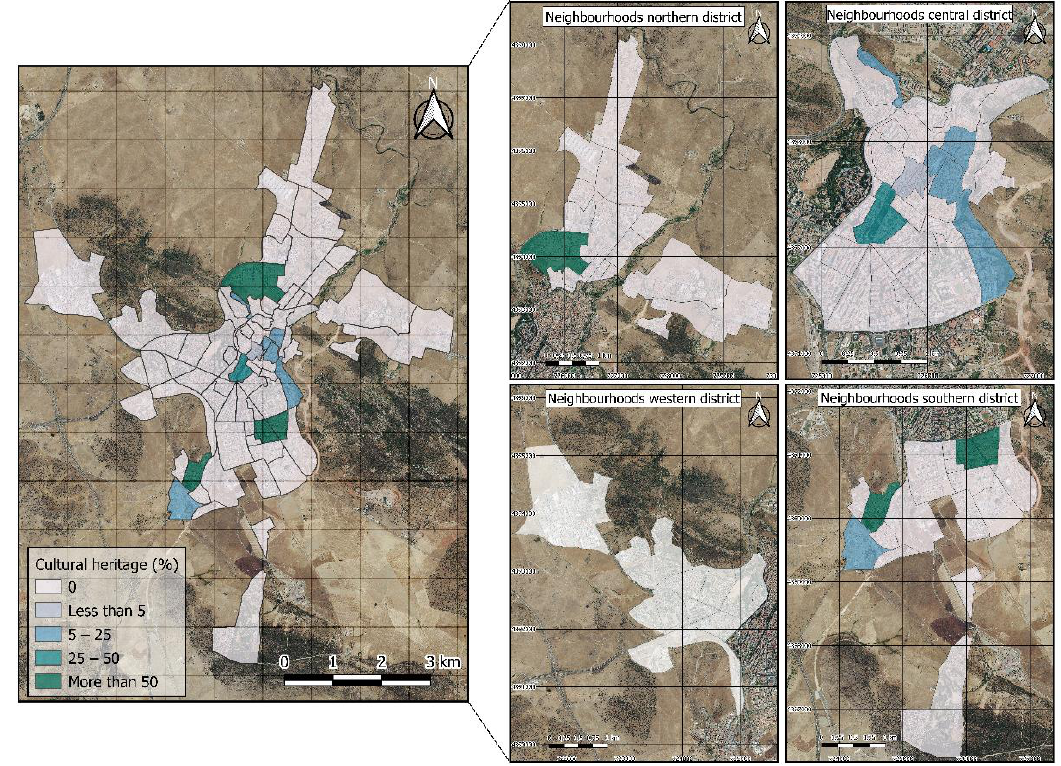
Figure 12. Cultural heritage